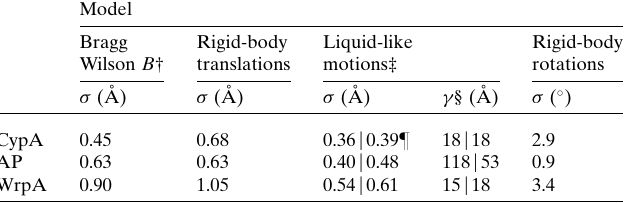
Table 3 Refined model parameters.